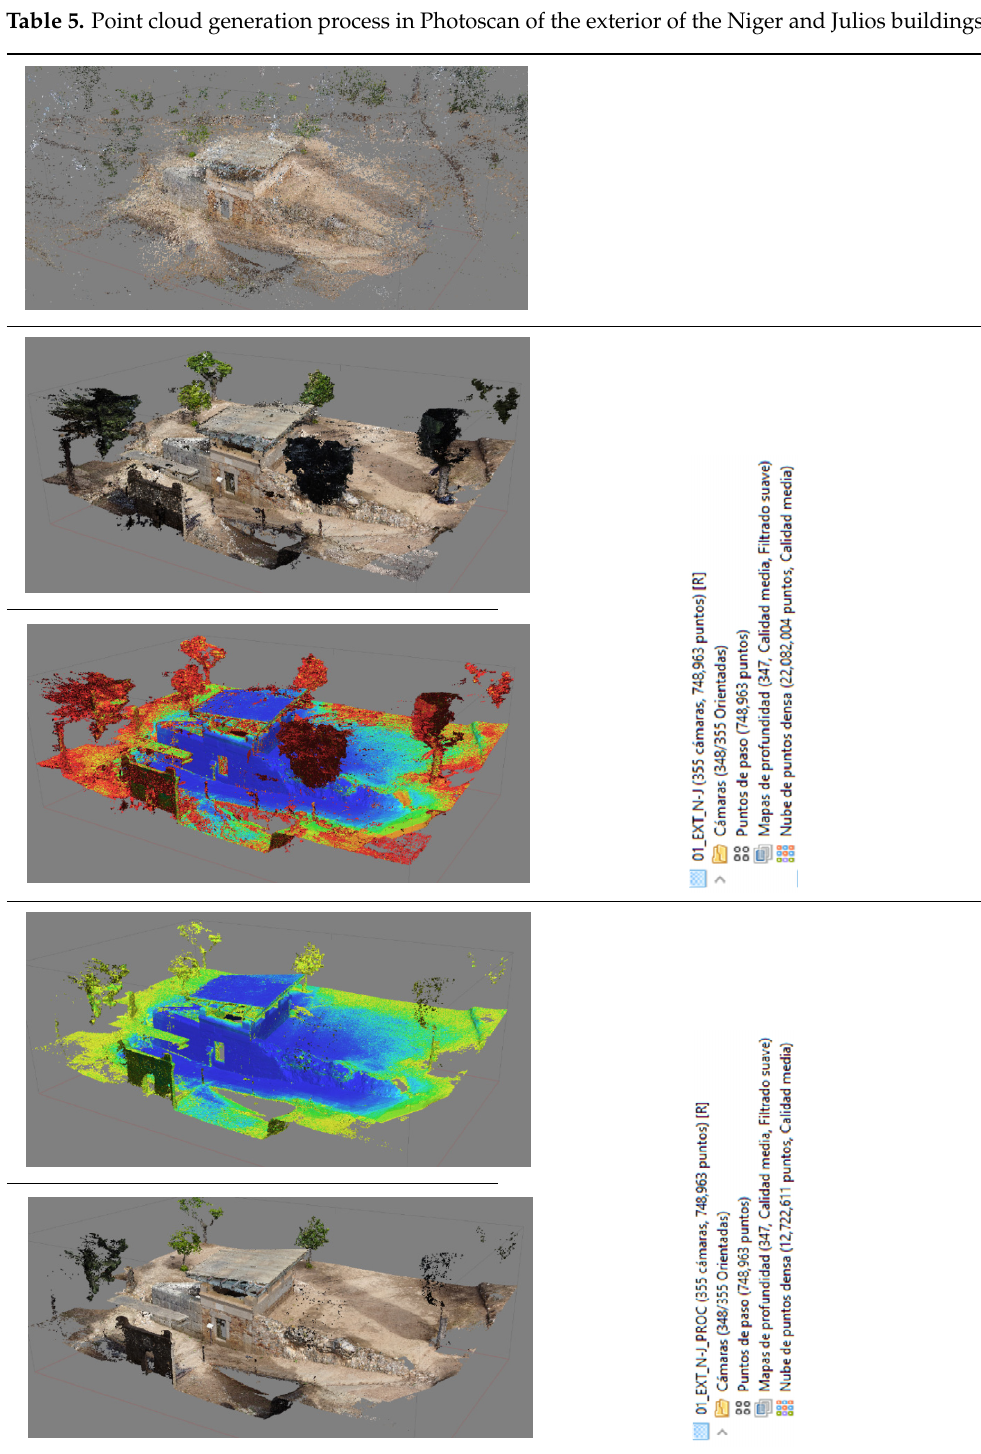
Remote Sens. 2022 , 14 , 3319 Remote Sens. 2022 , 14 , 3319 Table 5. Point cloud generation process in Photoscan of the exterior of the Niger and Julios build- Table 5. Point cloud generation process in Photoscan of the exterior of the Niger and Julios build- Table 5. Point cloud generation process in Photoscan of the exterior of the Niger and Julios build- Table 5. Point cloud generation process in Photoscan of the exterior of the Niger and Julios build- Table 5. Point cloud generation process in Photoscan of the exterior of the Niger and Julios buildings. ings. Table 5. Point cloud generation process in Photoscan of the exterior of the Niger and Julios build- ings. ings. ings.